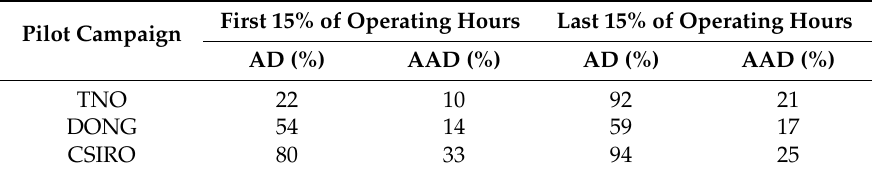
Table 5. Comparison for average deviations (AD) and absolute average deviations (AAD) for dissolved iron during first and last 15% of operating hours of